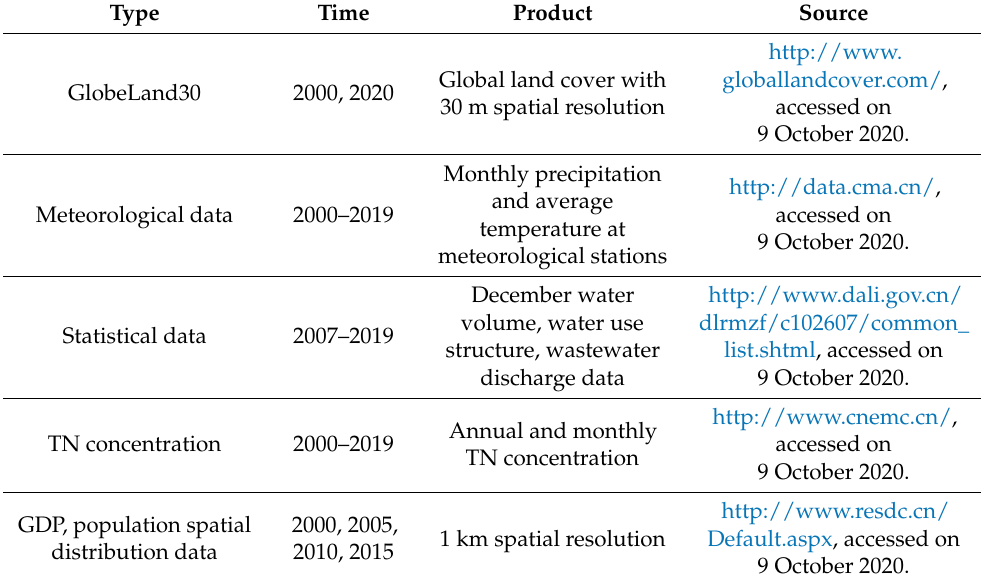
Table 1. Data and sources used in the